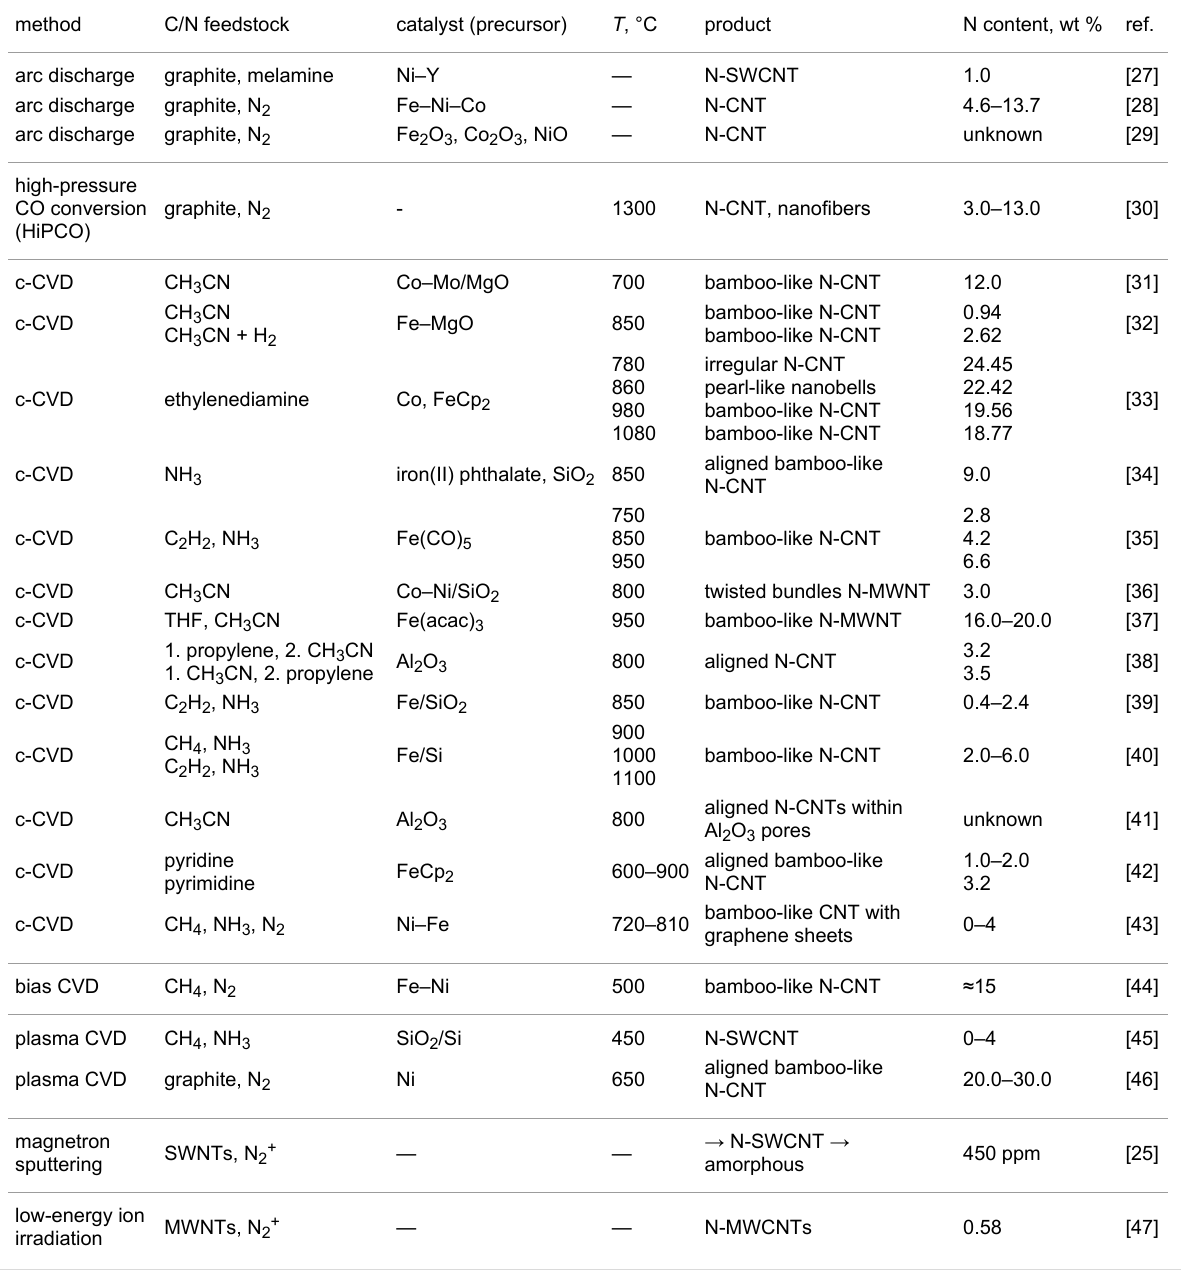
Table 1: Literature overview of representative synthetic pathways toward